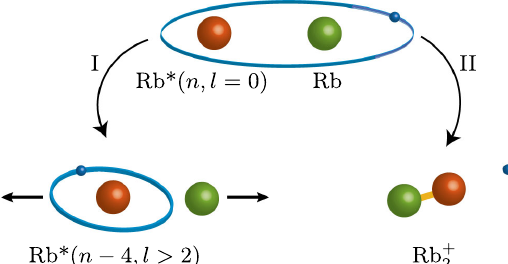
FIG. 1. The two observed reaction channels for a single Rydberg atom in an ultracold and dense environment. The red sphere depicts the Rydberg ionic core, and the Rydberg electron is shown in blue, whereas the neutral atoms are shown in green. (I) The Rydberg atom changes its angular momentum, and both collision partners share the released energy as kinetic energy leading to an l -mixing reaction channel. (II) A deeply bound Rb þ 2 molecular ion is formed in an associative ionization reaction via